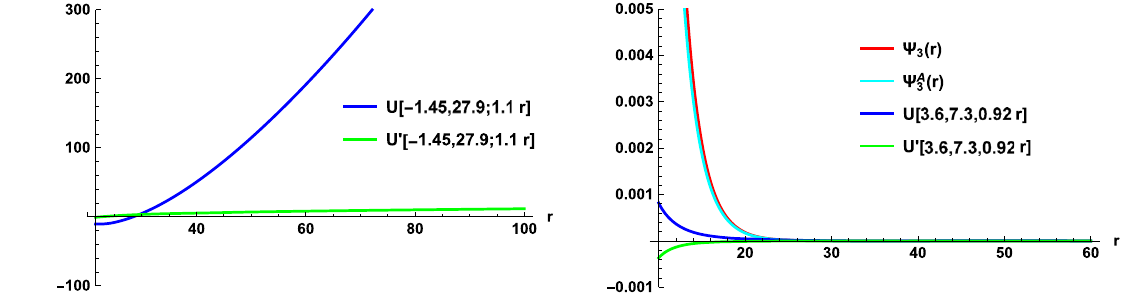
Fig. 4 (Left) Hypergeometric function U [− 1 . 45 , 27 . 9 , 1 . 1 r ] and its first derivative U (cid:15) [− 1 . 45 , 27 . 9 , 1 . 1 r ] represent (left) Fig. 2. (Right) Far-region scalar function (cid:17) 3 ( r ) and its asymptotic form (cid:17) A